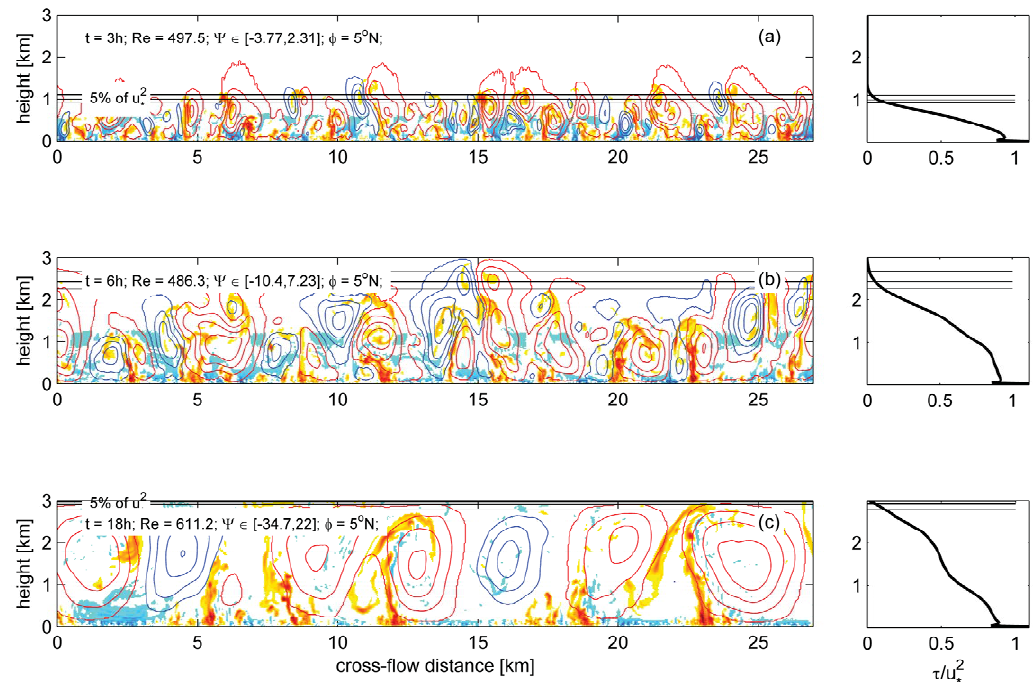
Fig. 9. Cross-flow sections ( yz planes) of the instant flow patterns in EW-EBL at 5 ◦ N. The panels are composed similarly to Fig. 8.